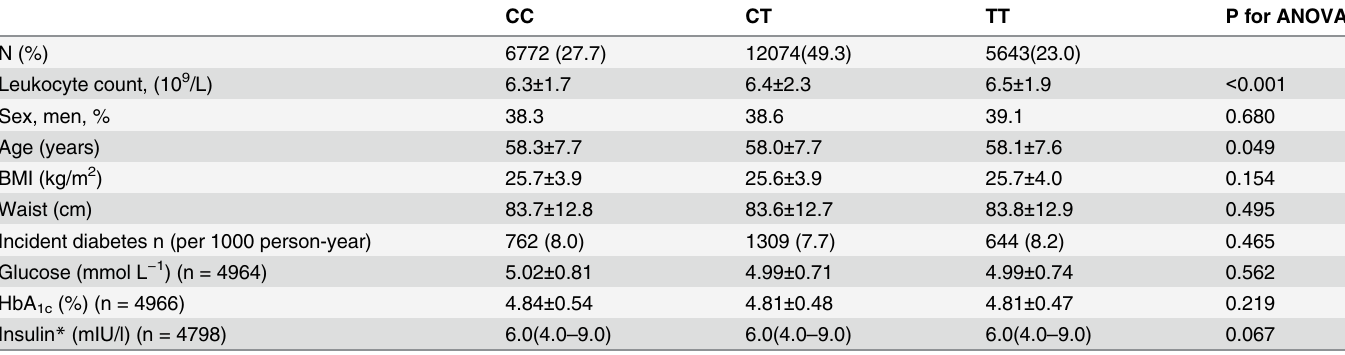
Table 3. Baseline characteristics of the study population divided by alleles (CC, CT, TT) of R262W (N = 24